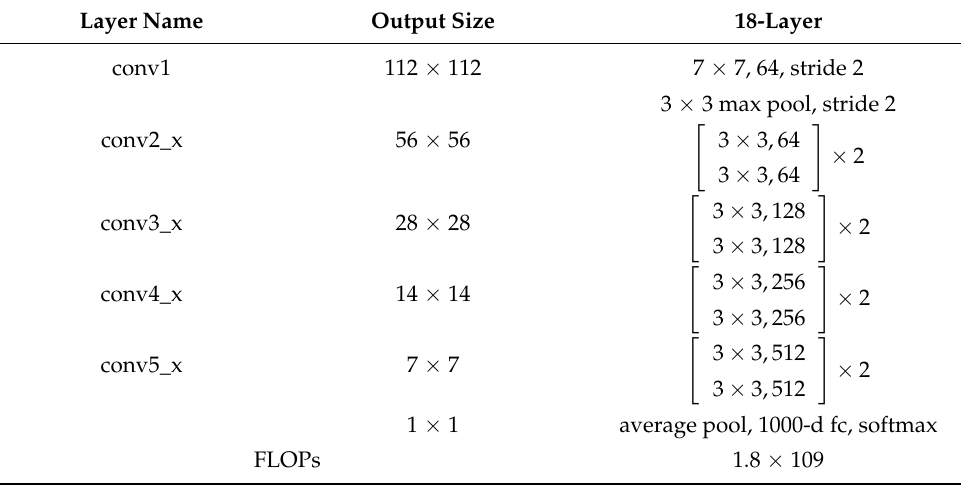
Table 1. Architectures for